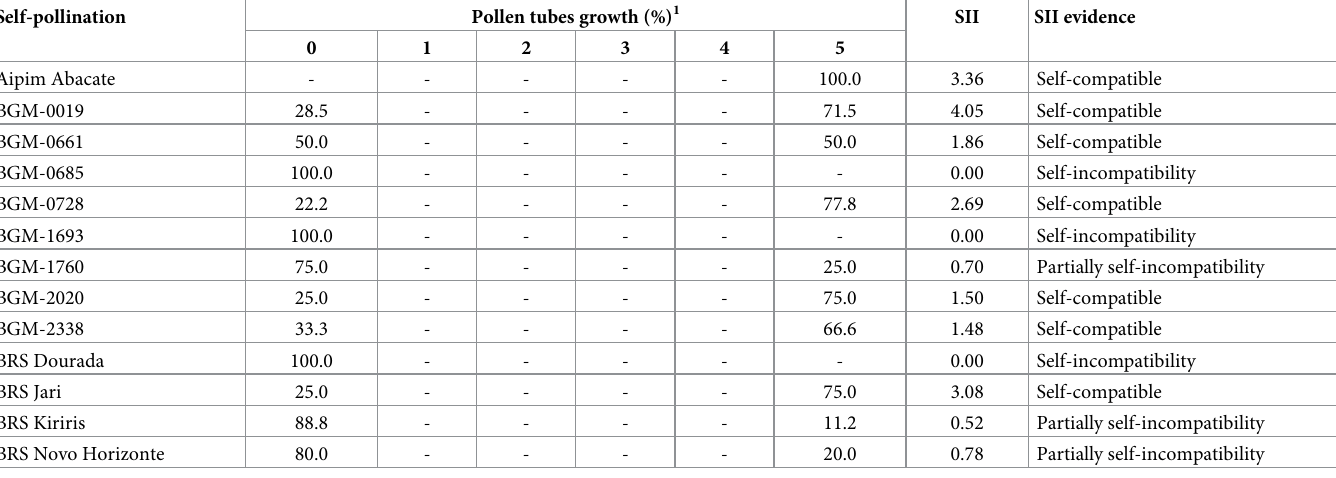
Table 5. Self-incompatibility index (SII) and pollen tube growth (PTG) of self-pollinations performed among different cassava clones.